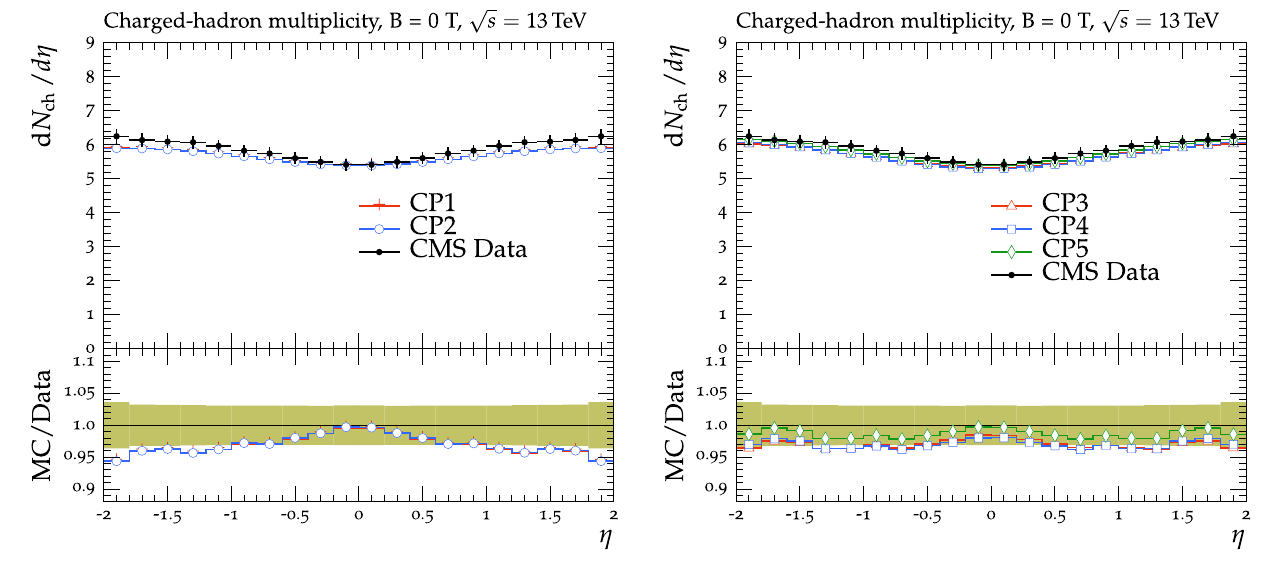
The ratios of simulations to the data (MC/Data) are also shown, where the shaded band indicates the total experimental uncertainty in the data. √ s = 13TeV Vertical lines drawn on the data points refer to the total uncertainty in the data. Vertical lines drawn on the MC points refer to the statistical uncertainty in the predictions. Horizontal bars indicate the associated bin